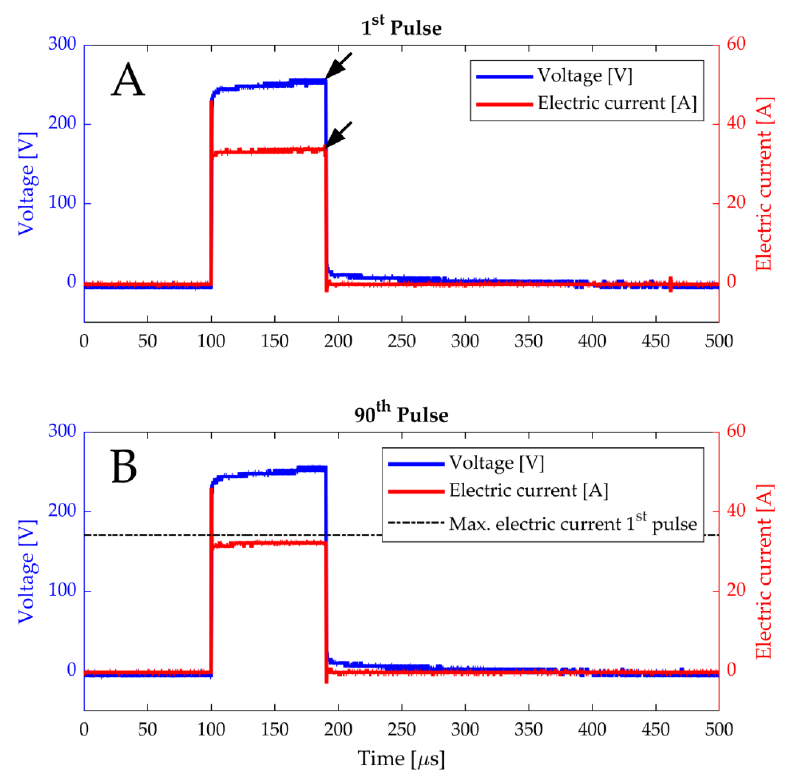
Figure 5. The electric current and voltage for 1250 V · cm − 1 of ( A ) the first and ( B ) the 90th (last) pulse number as a function of time. In ( B ), a horizontal line was added to show the maximum of the electric current at the end of the first pulse. Also note that the black arrows in ( A ) represent the values of the electric current and voltage used in the calculation of the average electrical specific conductivity ( σ av [S · m − 1 ]).